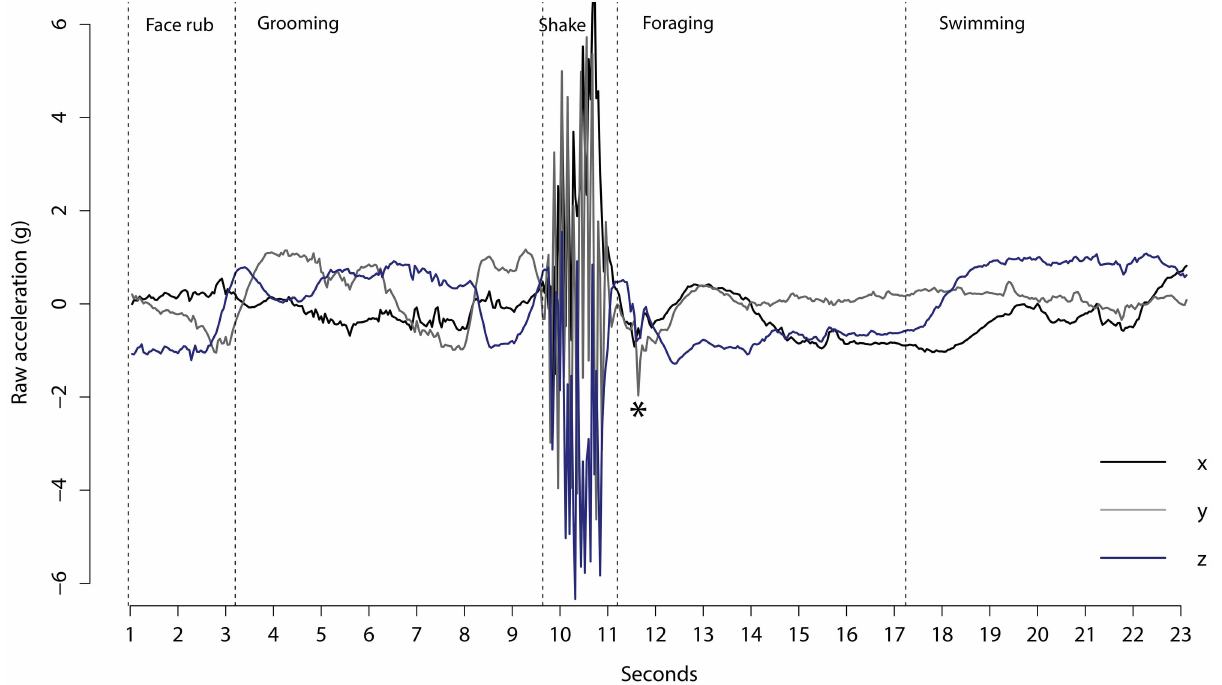
Fig 3. Example of raw acceleration data for a series of behaviours. The * representsa fish capture in the water column.